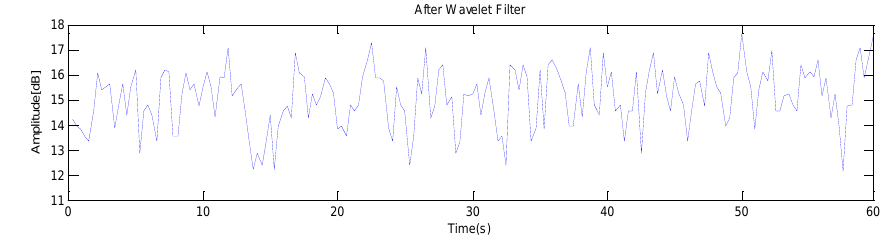
Figure 20. Filtered WCI for normal breathing using Figure 20 . Filtered WCI for normal breathing using C-Band.